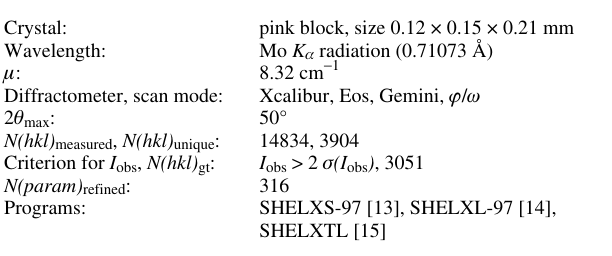
Table 1. Data collection and